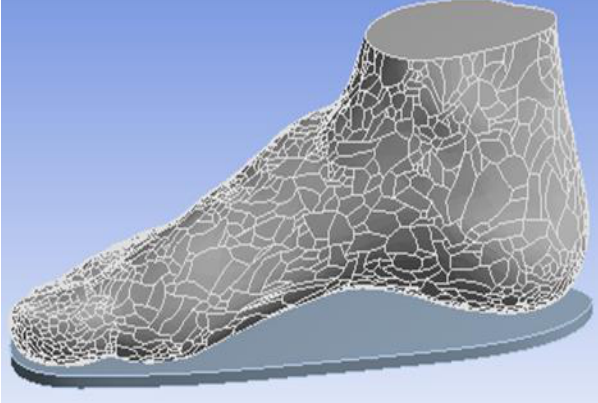
Figure 1. Whole foot model geometry .